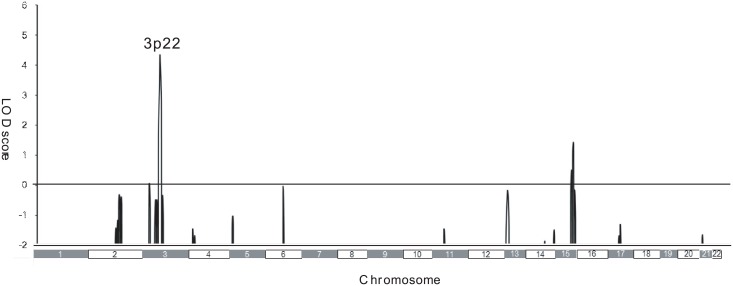
Genome-wide linkage analysis in two Japanese familial episodic pain syndrome families.Genome-wide linkage analysis was performed for eight affected and five unaffected members in Family 1, and four affected and four unaffected members in Family 2. Parametric linkage analysis was performed using 386 genetic markers (including 382 microsatellite genetic markers) that were 10 cM apart and covered 22 autosomes, as well as additional SNP markers. GeneHunter software was used.